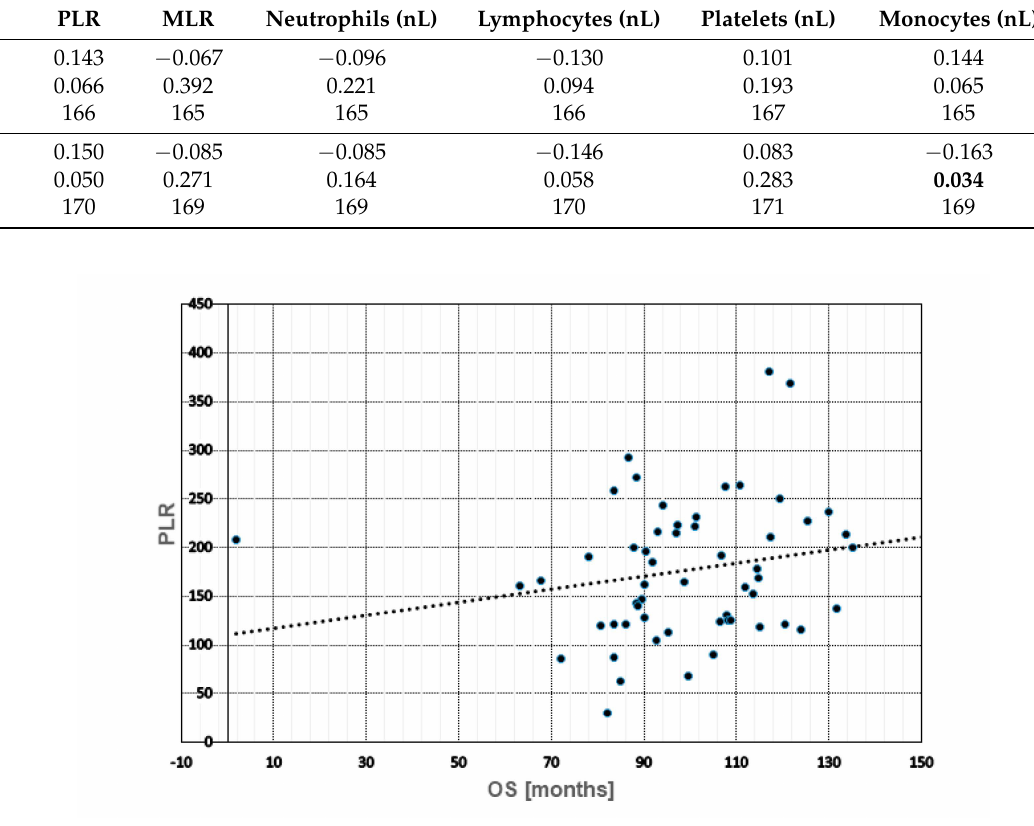
Figure 3. Scatterplot with regression line between blood cells and DTCs. No significant correlations were found for NLR, PLR and MLR with DTCs; however, DTC-positive patients, harboring a lower PLR, had significantly shorter OS ( p = 0.043).